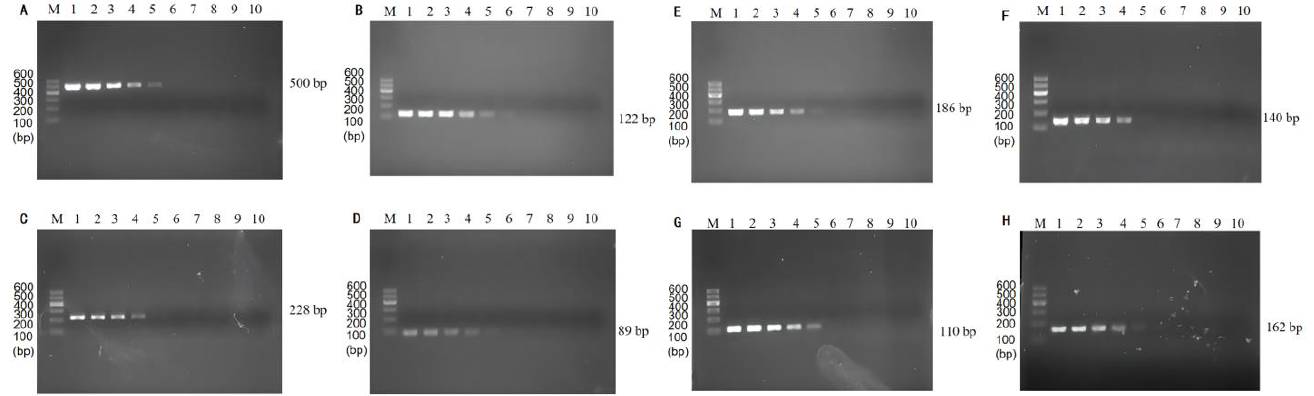
Figure 3. Results of single PCR sensitivity. Lane M: DNA marker B 600; Lane 1~8: Dilute the DNA template to the original concentration of 1, 10 − 1 , 10 −2 , 10 −3 , 10 −4 , 10 −5 , 10 −6 , 10 − 7 , 10 −8 , and 10 −9 times, respectively. ( A ) The initial concentration of the template for P. putida is 140 ng/μL; ( B ) The initial concentration of the template for V. alginolyticus is 180 ng/μL; ( C ) The initial concentration of the template for V. vulnificus is 170 ng/μL; ( D ) The initial concentration of the template for V. parahaemolyticus is 200 ng/μL; ( E ) The initial concentration of the template for C. sakazakii is 150 ng/μL; ( F ) The initial concentration of the template for S. flexneri is 130 ng/μL; ( G ) The initial concentration of the template for E. coli O157:H7 is 150 ng/μL; ( H ) The initial concentration of the template for L. monocytogenes is 150 ng/μL.